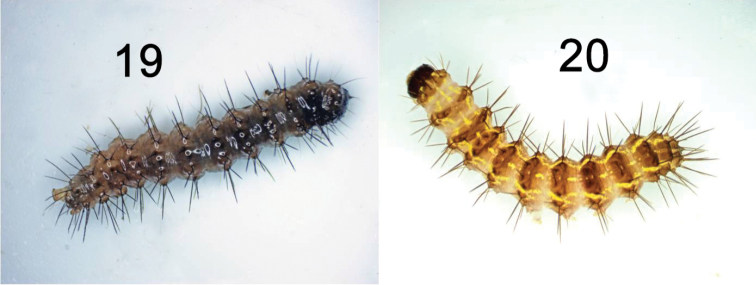
Last instar larvae of 19Hypoprepialampyroides and 20Hypoprepiacadaverosa, preserved.